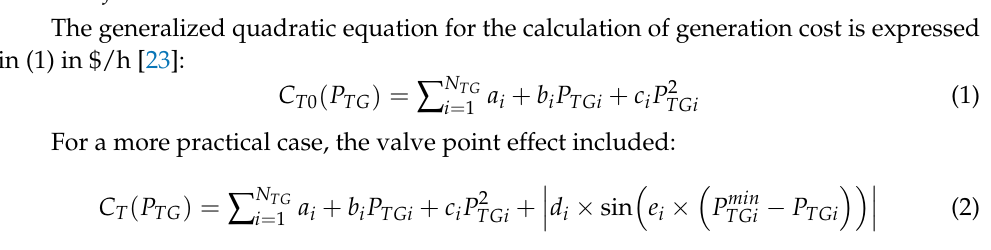
Figure 1. Adapted IEEE 30-bus scheme with power units and FACTS policies [23].